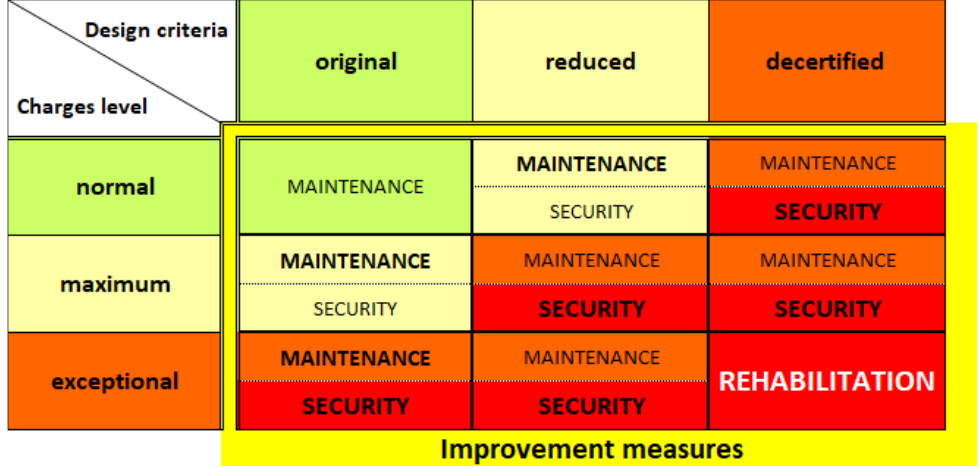
Figure 17. Concept of the grid for operational safety improvement measures.